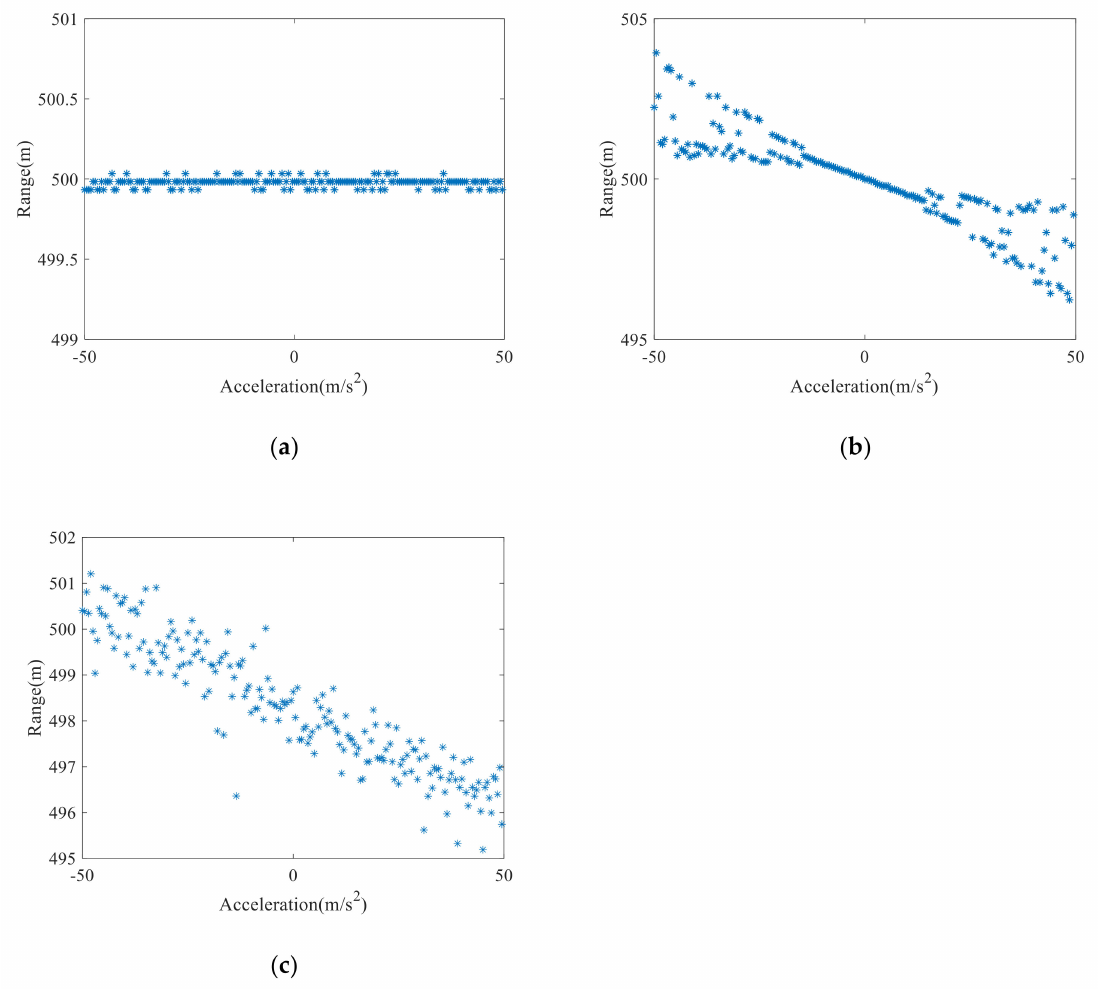
Figure 9. The ranging results under different vibration parameters: ( a ) the proposed method; ( b ) the Doppler frequency shift method; ( c ) the three-point